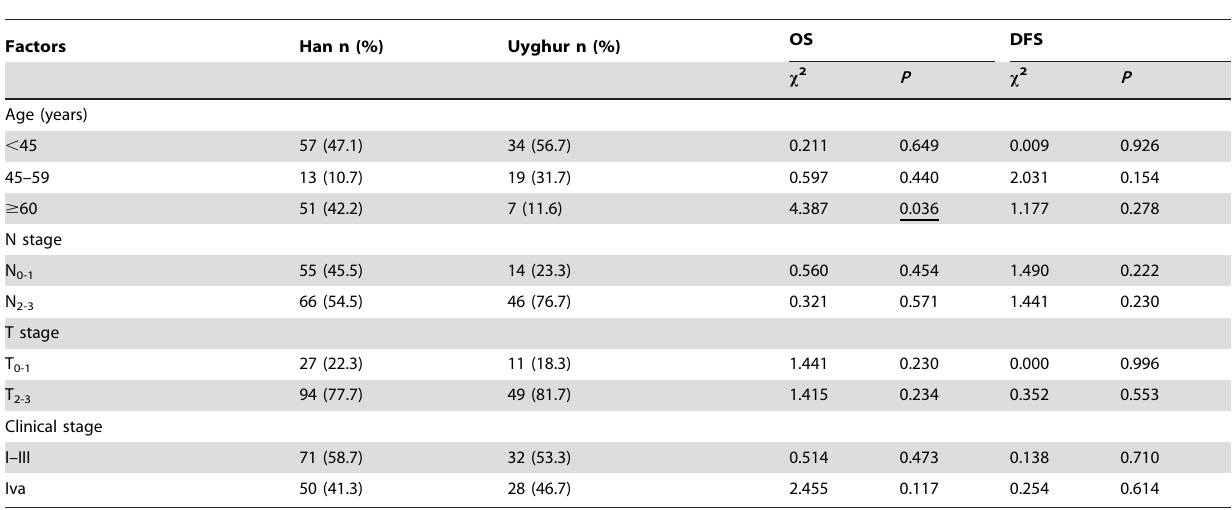
Table 3. Univariate analysis of OS and DFS for Han and Uyghur patient.